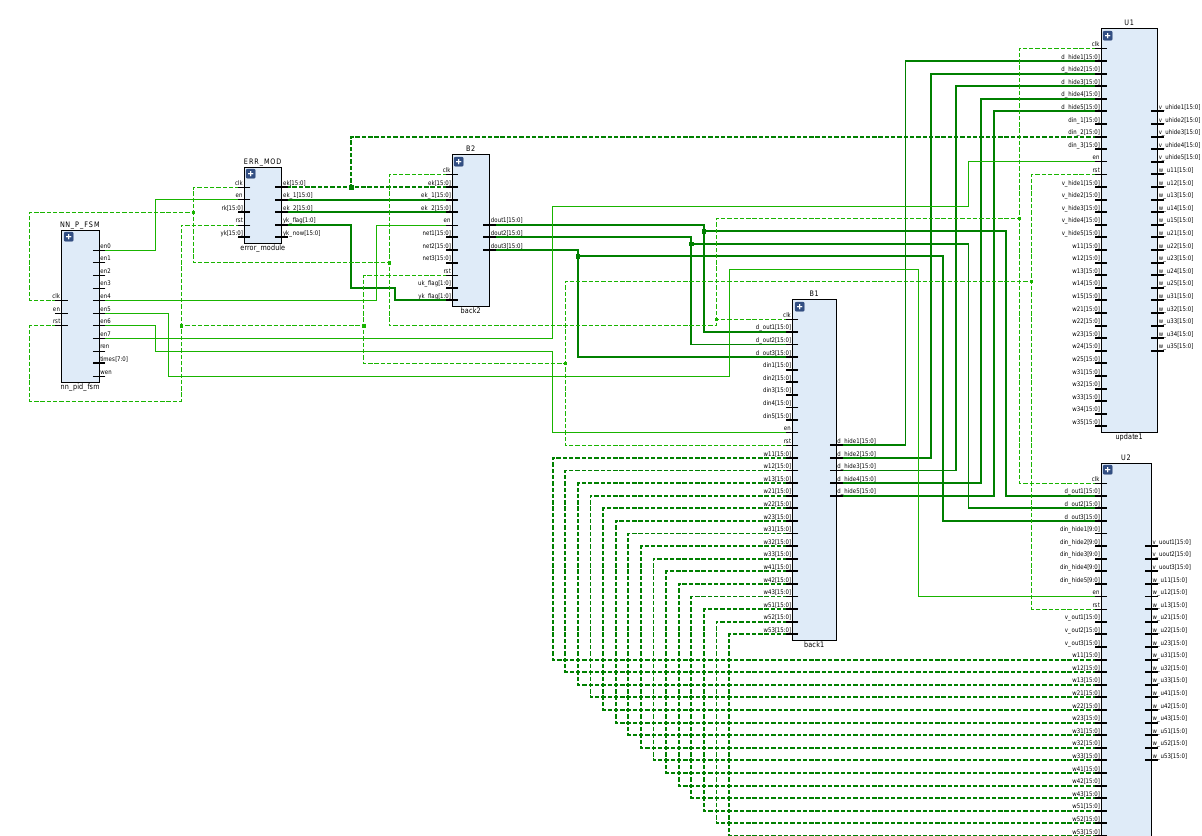
Figure 11. RTL schematic diagram of backpropagation